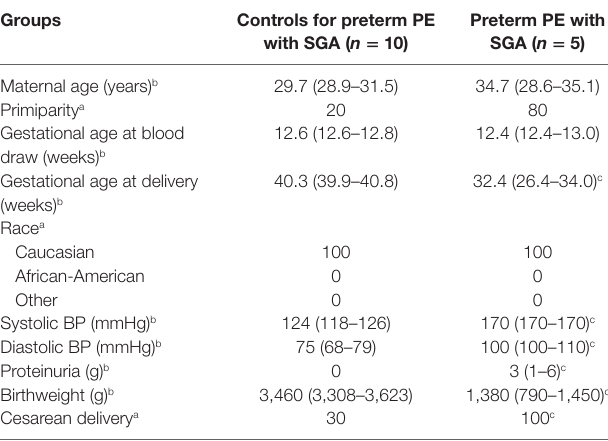
TaBle 5 | Demographics of Hungarian women included in the maternal blood multiple reaction monitoring proteomics study. groups controls for preterm Pe with sga ( n =